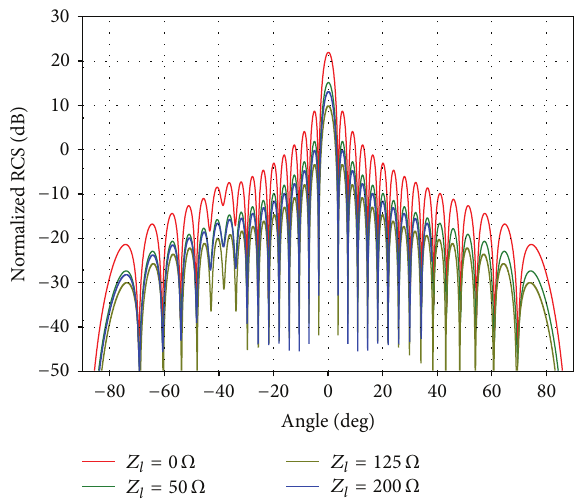
Figure 19: Effect of varying the impedance terminating the isolation port of couplers on the broadside RCS of a series-fed collinear dipole array in the presence of coupling.